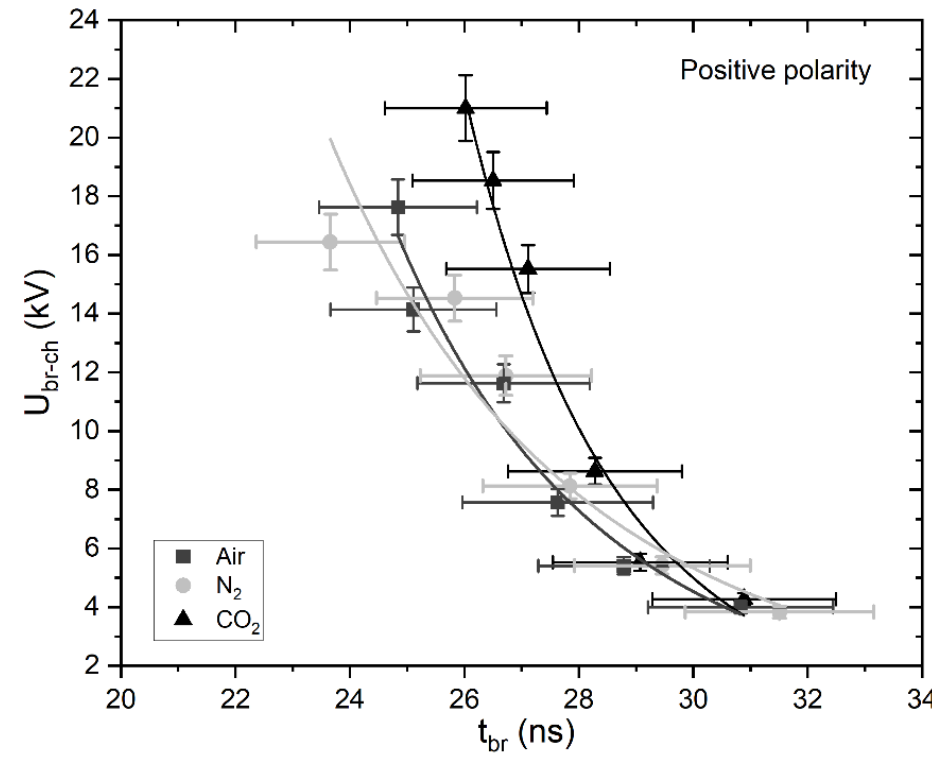
Figure 8. The breakdown voltage, U br-ch , as function of t br , positive polarity: ■ — air; ● — N 2 ; ▲ — CO 2 . Solid lines show fitting curves for each gas obtained by Equation (3). The error bars show the 95% confidence interval in the breakdown voltage and time to breakdown.